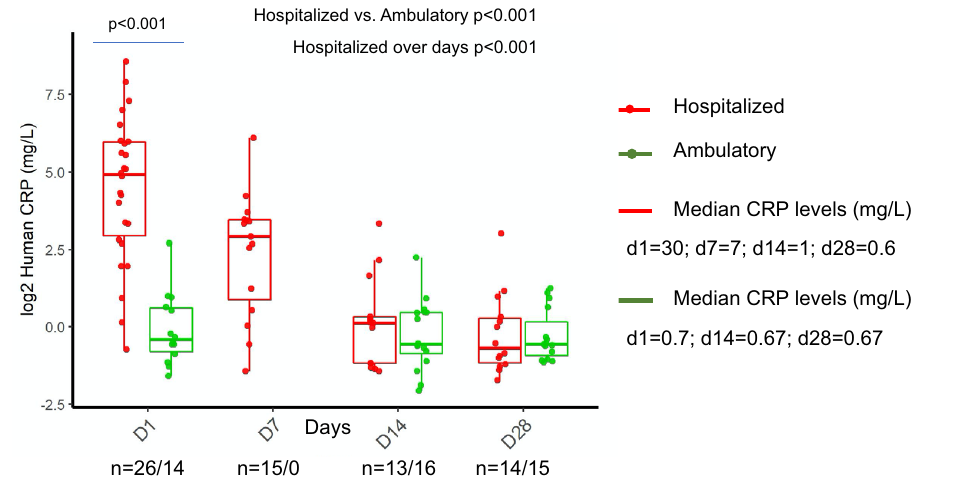
Figure 2. Longitudinal monitoring of C-reactive protein in hospitalized and ambulatory COVID-19 patients. Figure was created using ggplot2 package version 3.3.0. supported on R program software 38